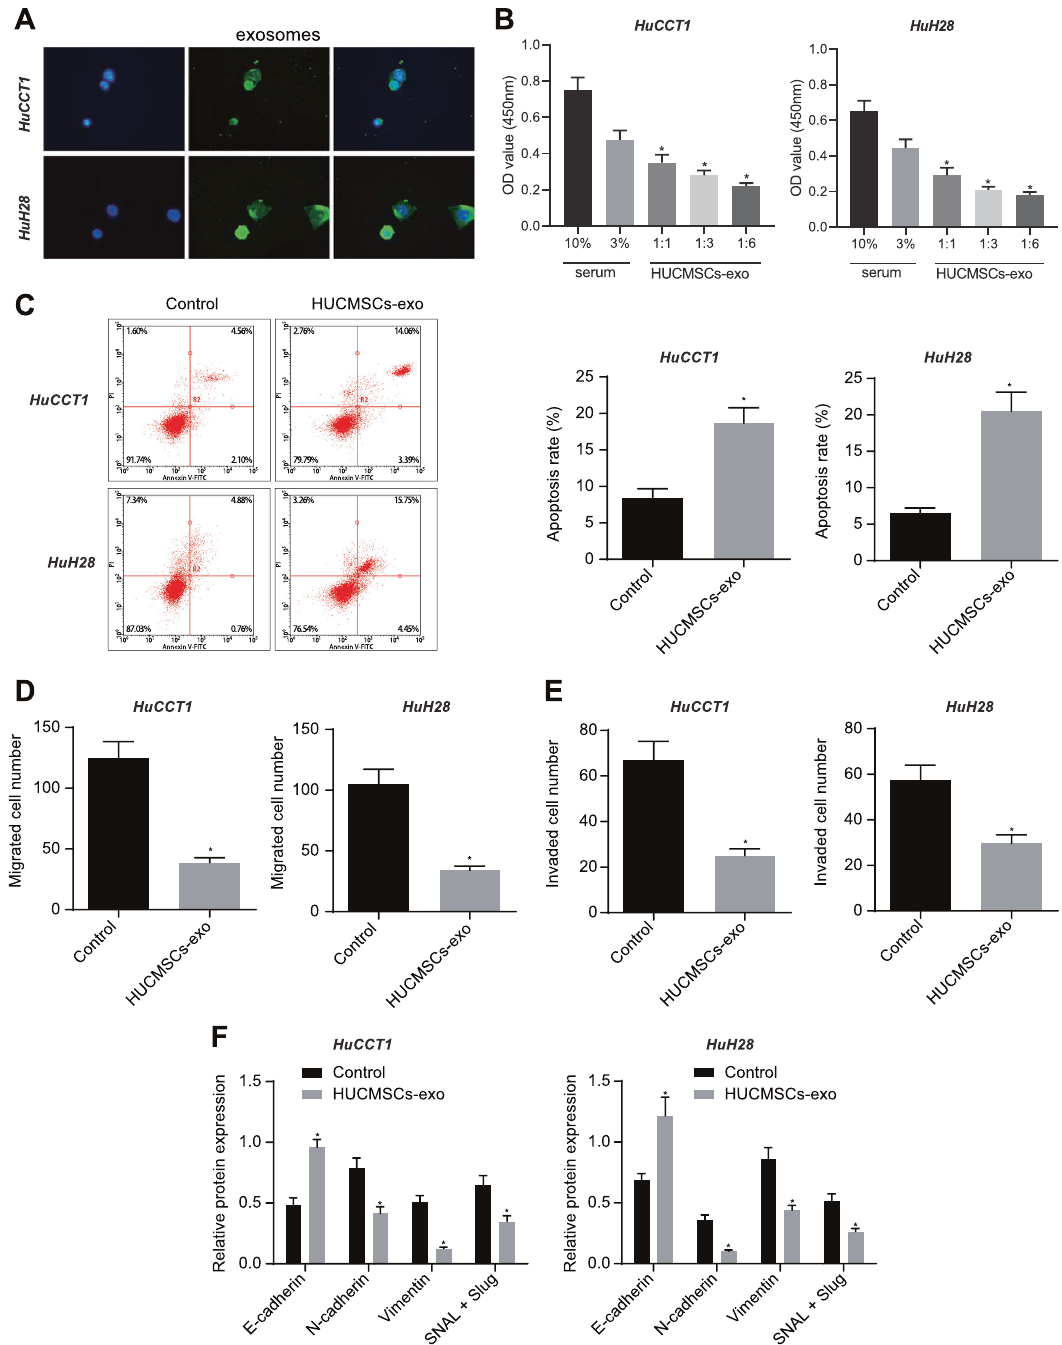
Fig. 7 HUCMSCs-exo can be delivered to CCA cells to promote apoptosis, represses cell proliferation, migration, invasion, and EMT in CCA cells. A Fluorescence microscope observation of internalization of PKH67-labeled HUCMSCs-exo by HuCCT1 and HuH28 cells. B Proliferative analysis of HuCCT1 and HuH28 cells. OD value was assessed at 450 nm using the CCK-8 kit. C Apoptosis evaluation of HuCCT1 and HuH28 cells. The samples were tested using fl ow cytometry. Statistical results are exhibited at the right of the panel. D Transwell assay of migration of HuCCT1 and HuH28 cells. E Matrigel-based Transwell assay of invasion of HuCCT1 and HuH28 cells. F Western blot assay of EMT related protein markers. In panels B – F , HuCCT1 and HuH28 cells were treated by HUCMSCs-exo, with FBS as a control. Comparison with the control group was conducted using unpaired t -test; the values at multiple groups were compared using one-way ANOVA followed by Tukey ’ s post-hoc tests; * means comparison against the control group, P < 0.05. The data are presented as mean ± standard deviation. Cell experiments were repeated three times